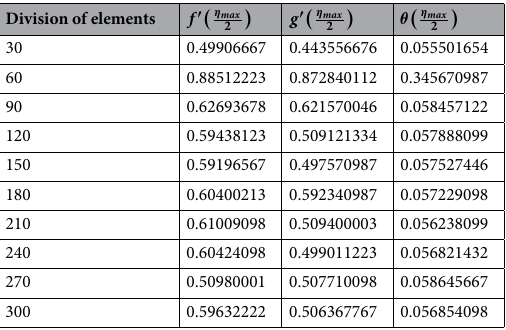
Table 3. Mesh-free investigation of temperature and velocities within 300 elements.